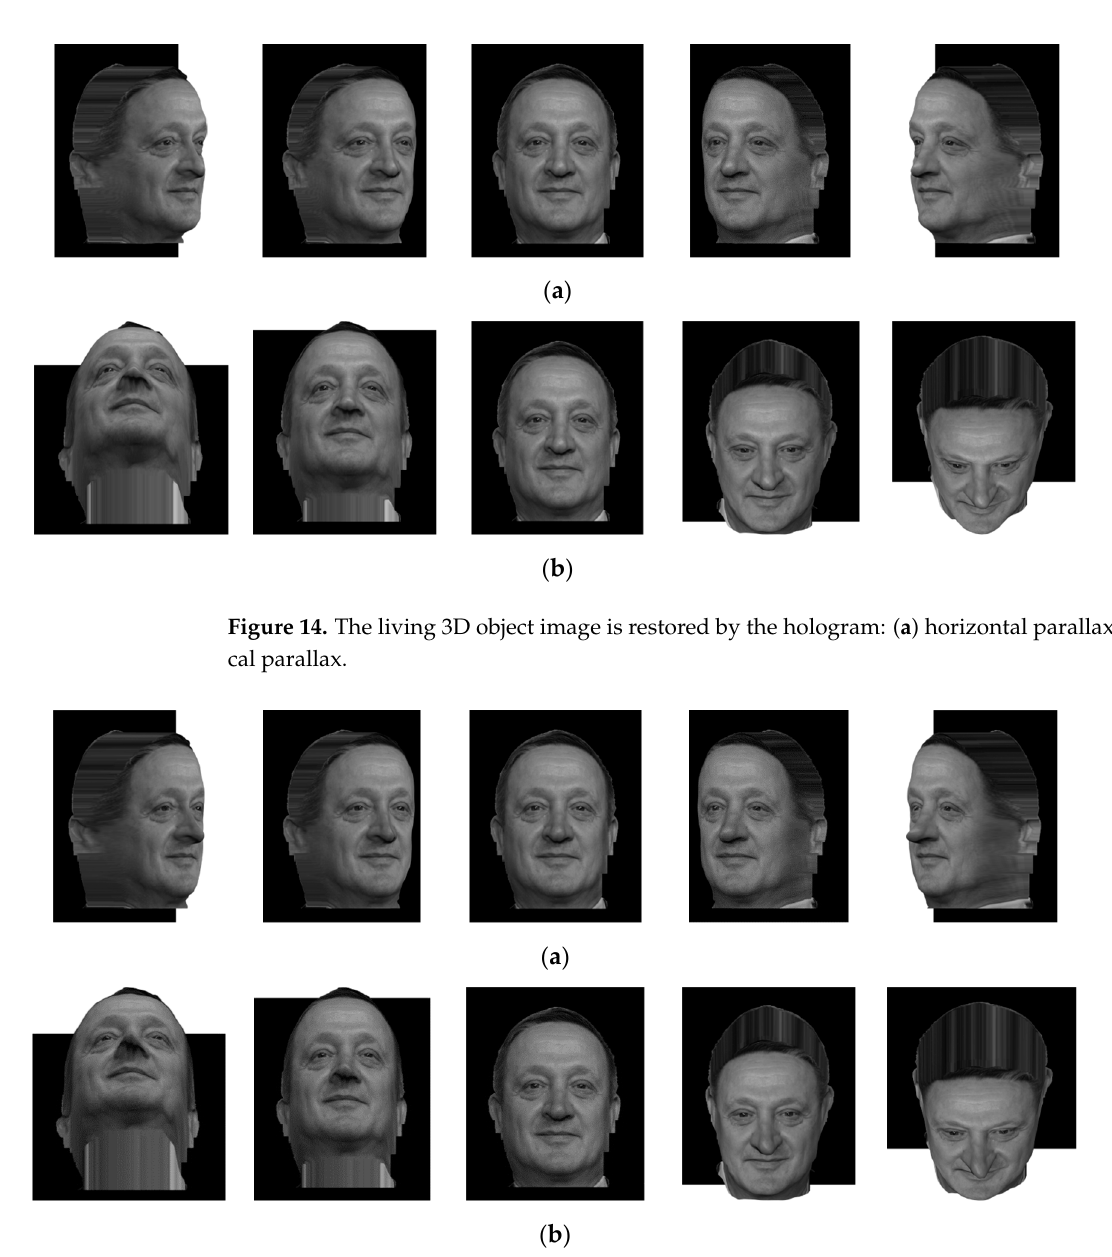
Figure 15. The living 3D object image is restored by the system of structured fringes: ( a ) horizontal parallax; ( b ) vertical parallax.